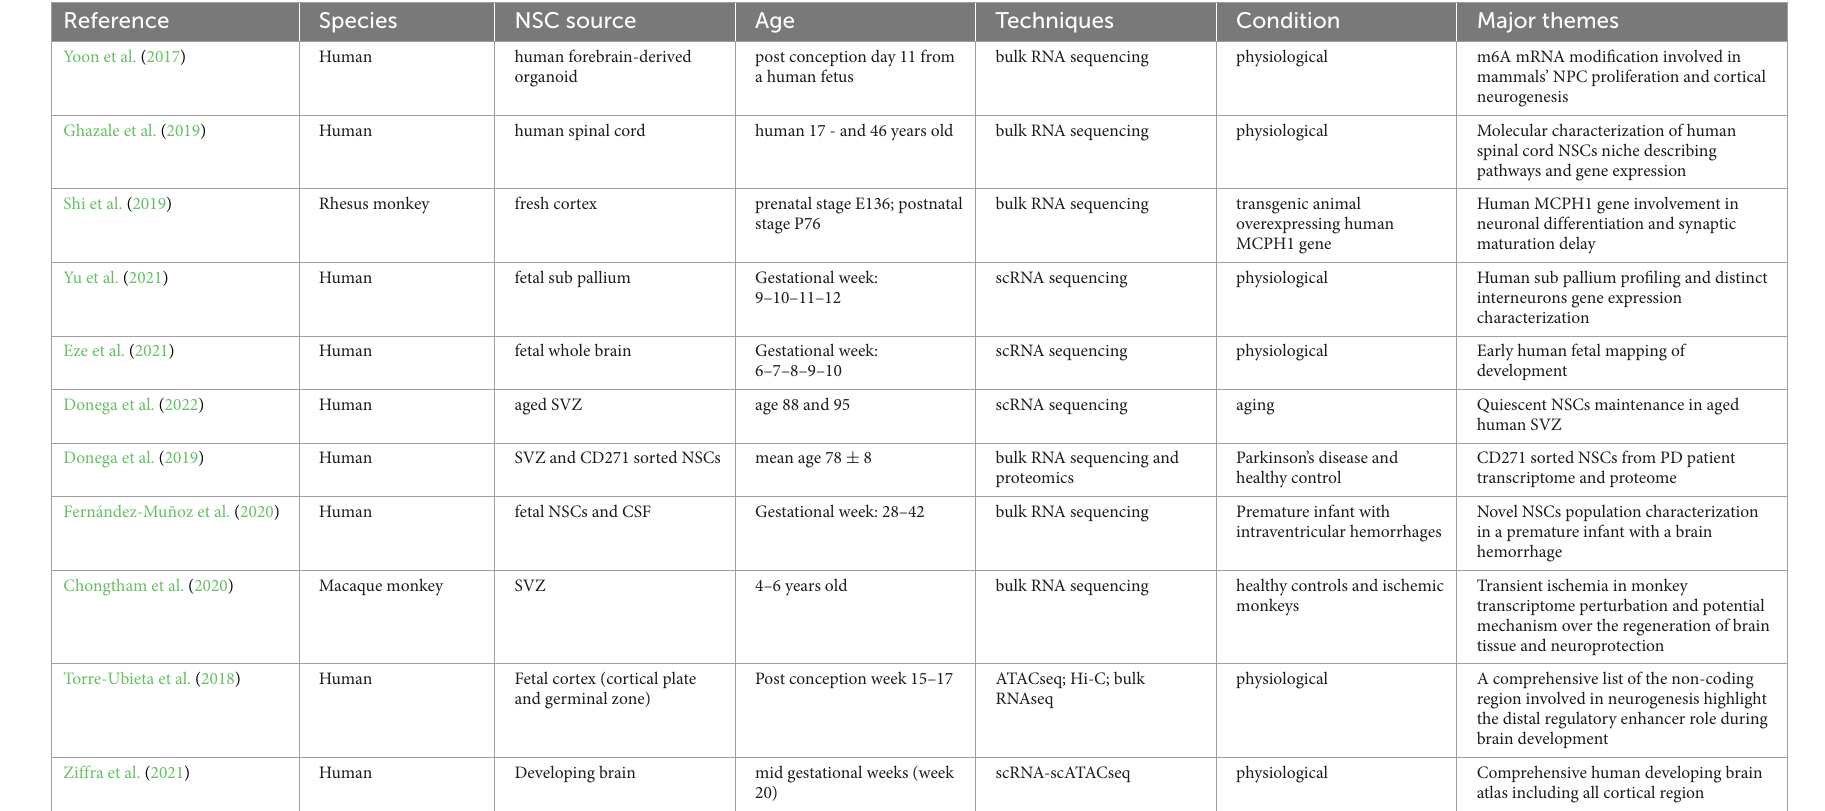
TABLE 1 Primate and human studies profiling endogenous NSCs by omics